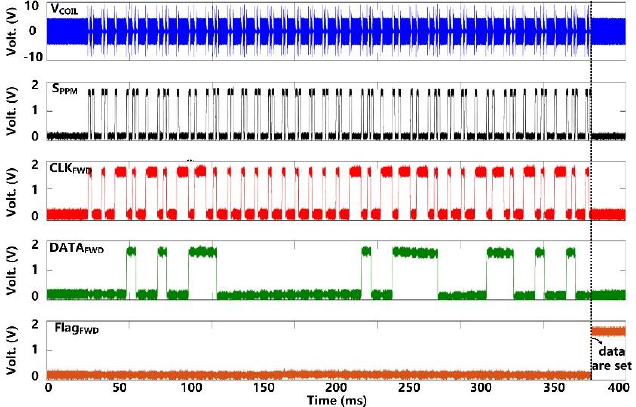
Figure 8. Measured results of forward data telemetry.